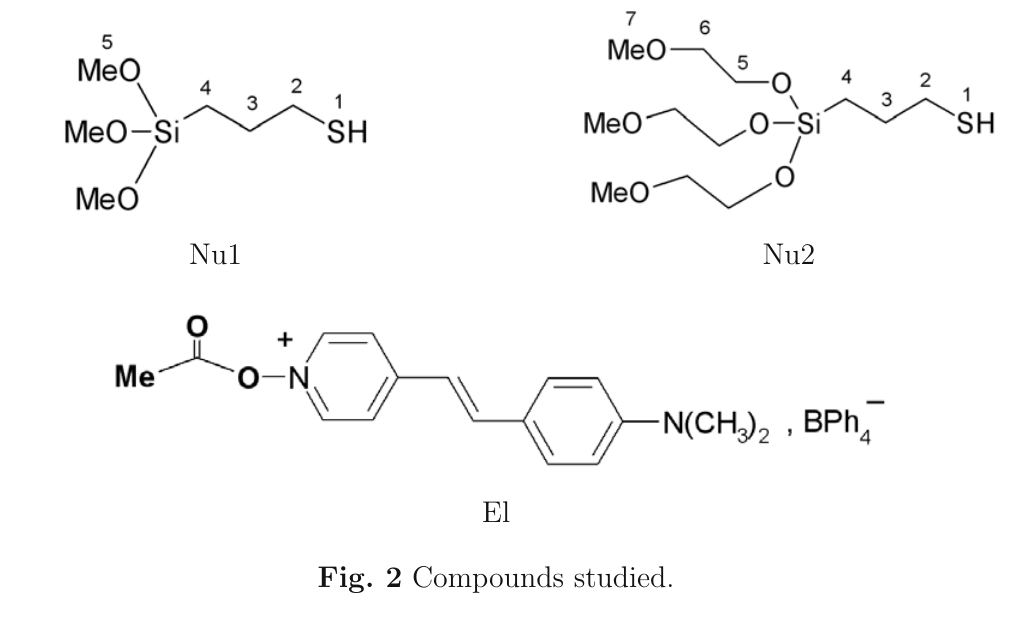
Fig. 2 Compounds